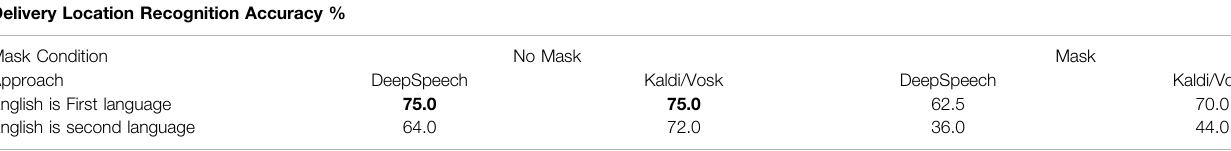
TABLE 1 | First-pass Recognition Accuracy compared between participants who learned English as their fi rst language vs. English as a second language. The best performance is highlighted in bold. Accuracy is averaged over all fi ve recordings for each condition from all 13 participants. Delivery Location Recognition Accuracy